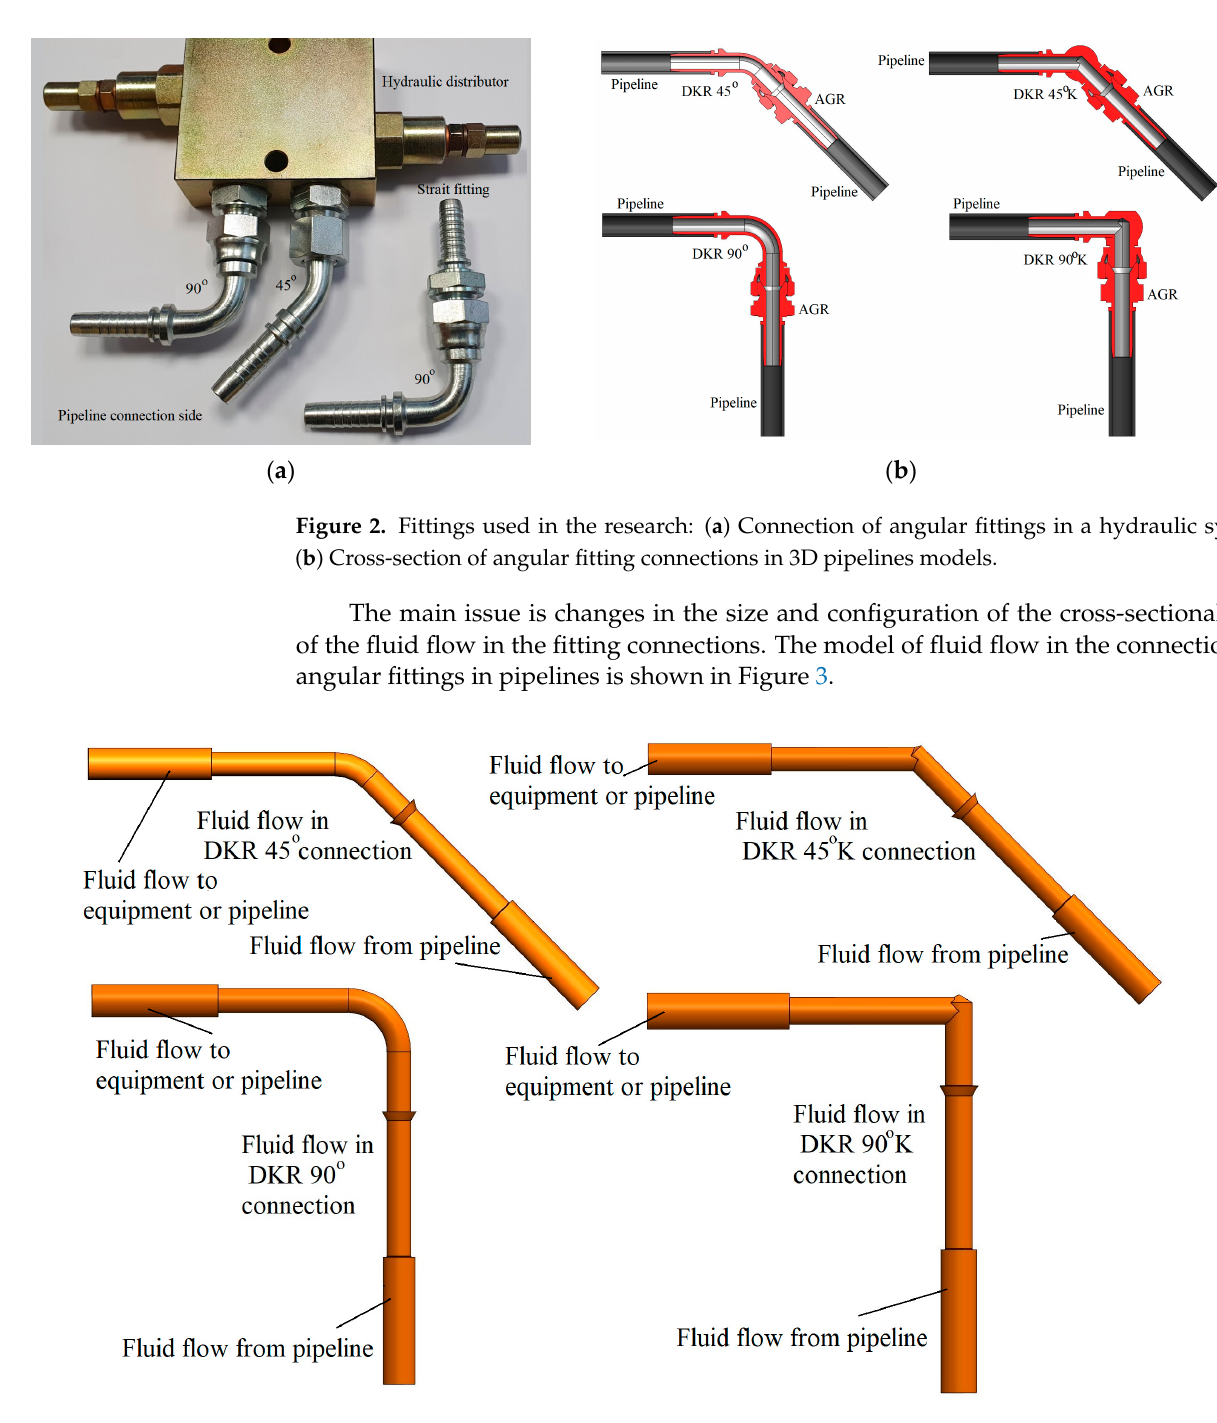
Figure 3. Model of fluid flow in the connections of angular fittings in pipelines.